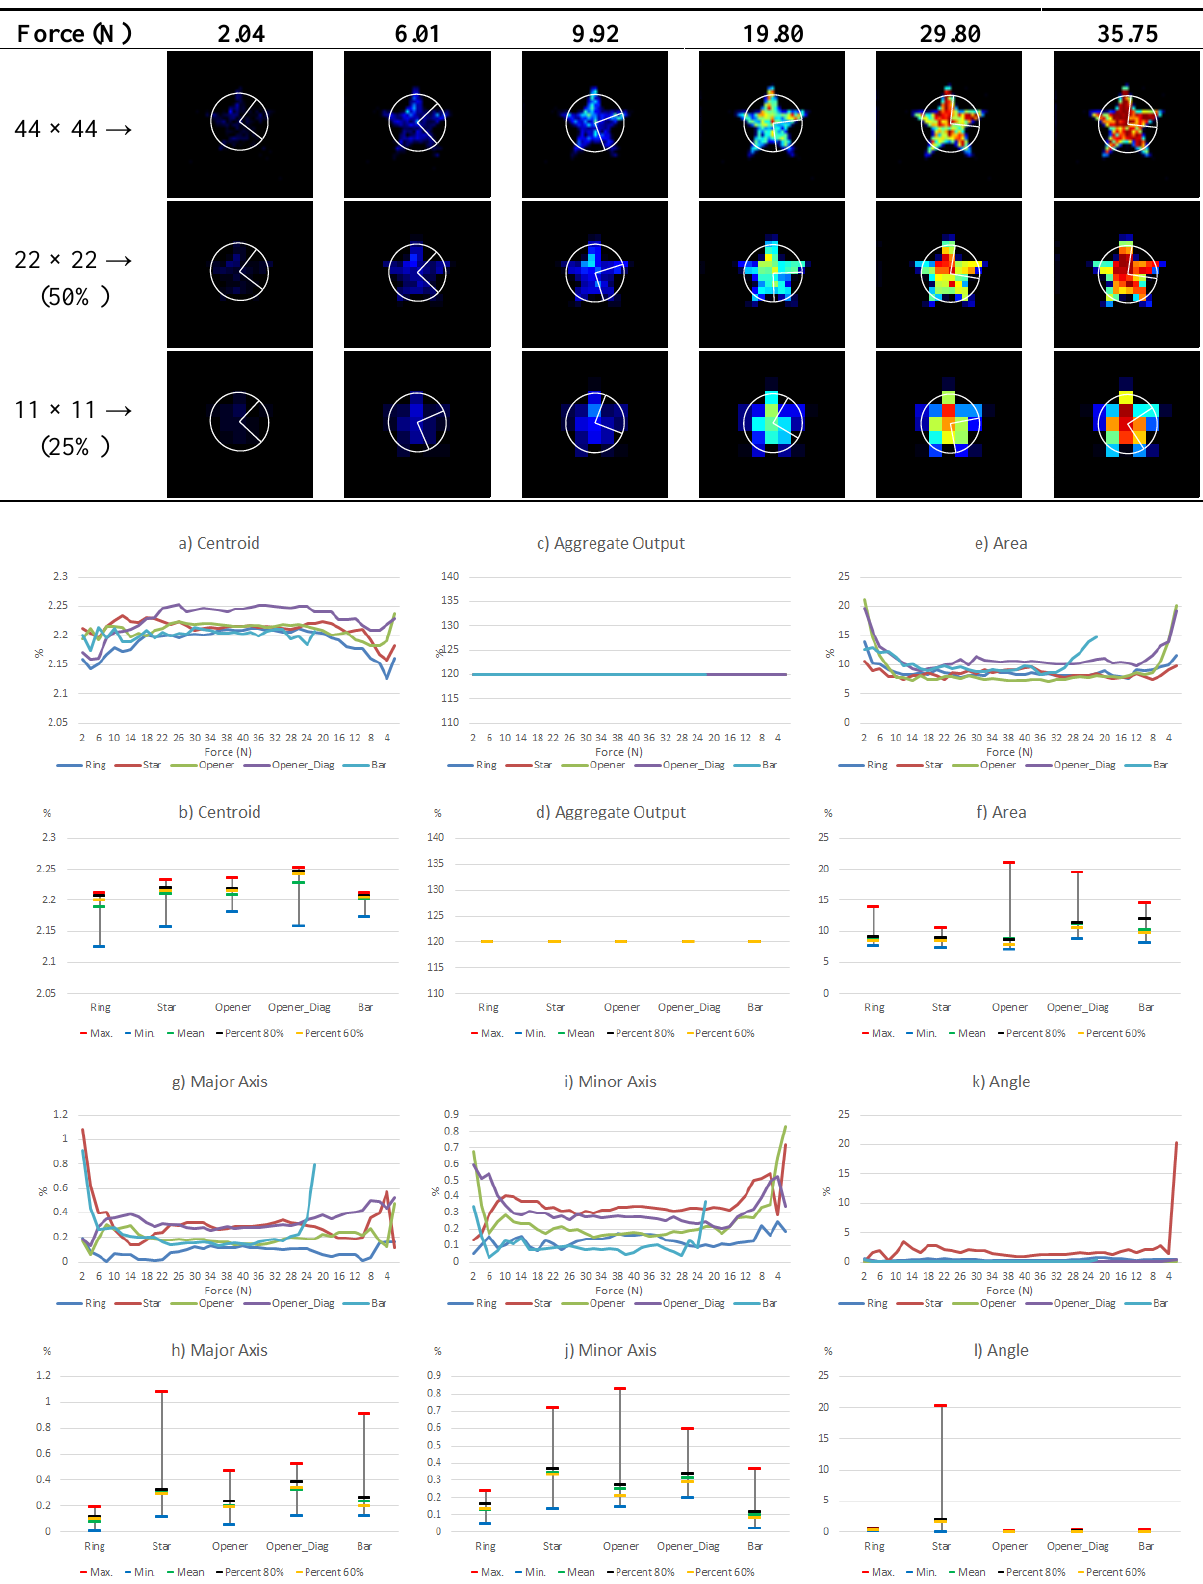
Table 9. Tactile images of the star obtained with the commercial sensor and resulting images from a decrease in resolution of 50% and 25%.